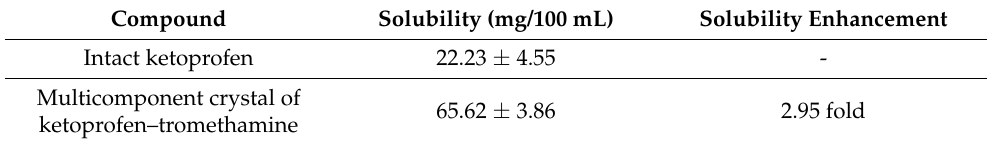
Table 2. The solubility data of intact ketoprofen and multicomponent crystal phase in distilled